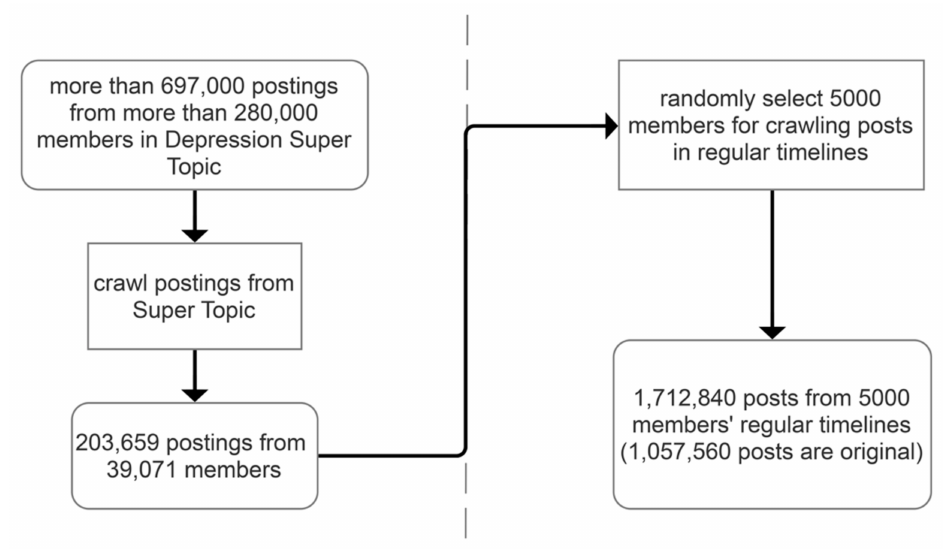
Figure 1. Flowchart of data collection from members of Depression Super